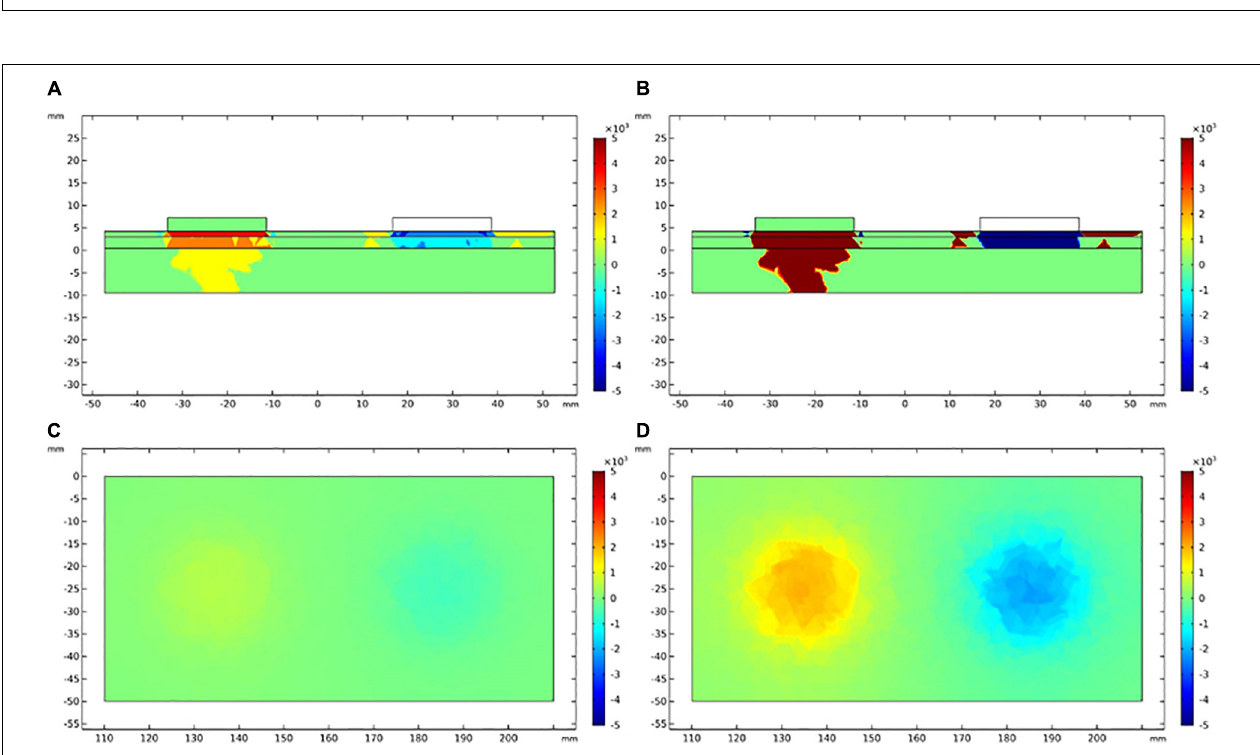
FIGURE 9 | Electric field gradient distribution in EA at different current intensity. (A) The longitudinal section of electric field gradient at 0.2 mA; (B) at 2.5 mA. (C) The cross-section (3 mm depth) of electric field gradient at 0.2 mA; (D) at 2.5 mA. Color bar indicates the magnitude of second order electrical field gradient (V/m 2 ).